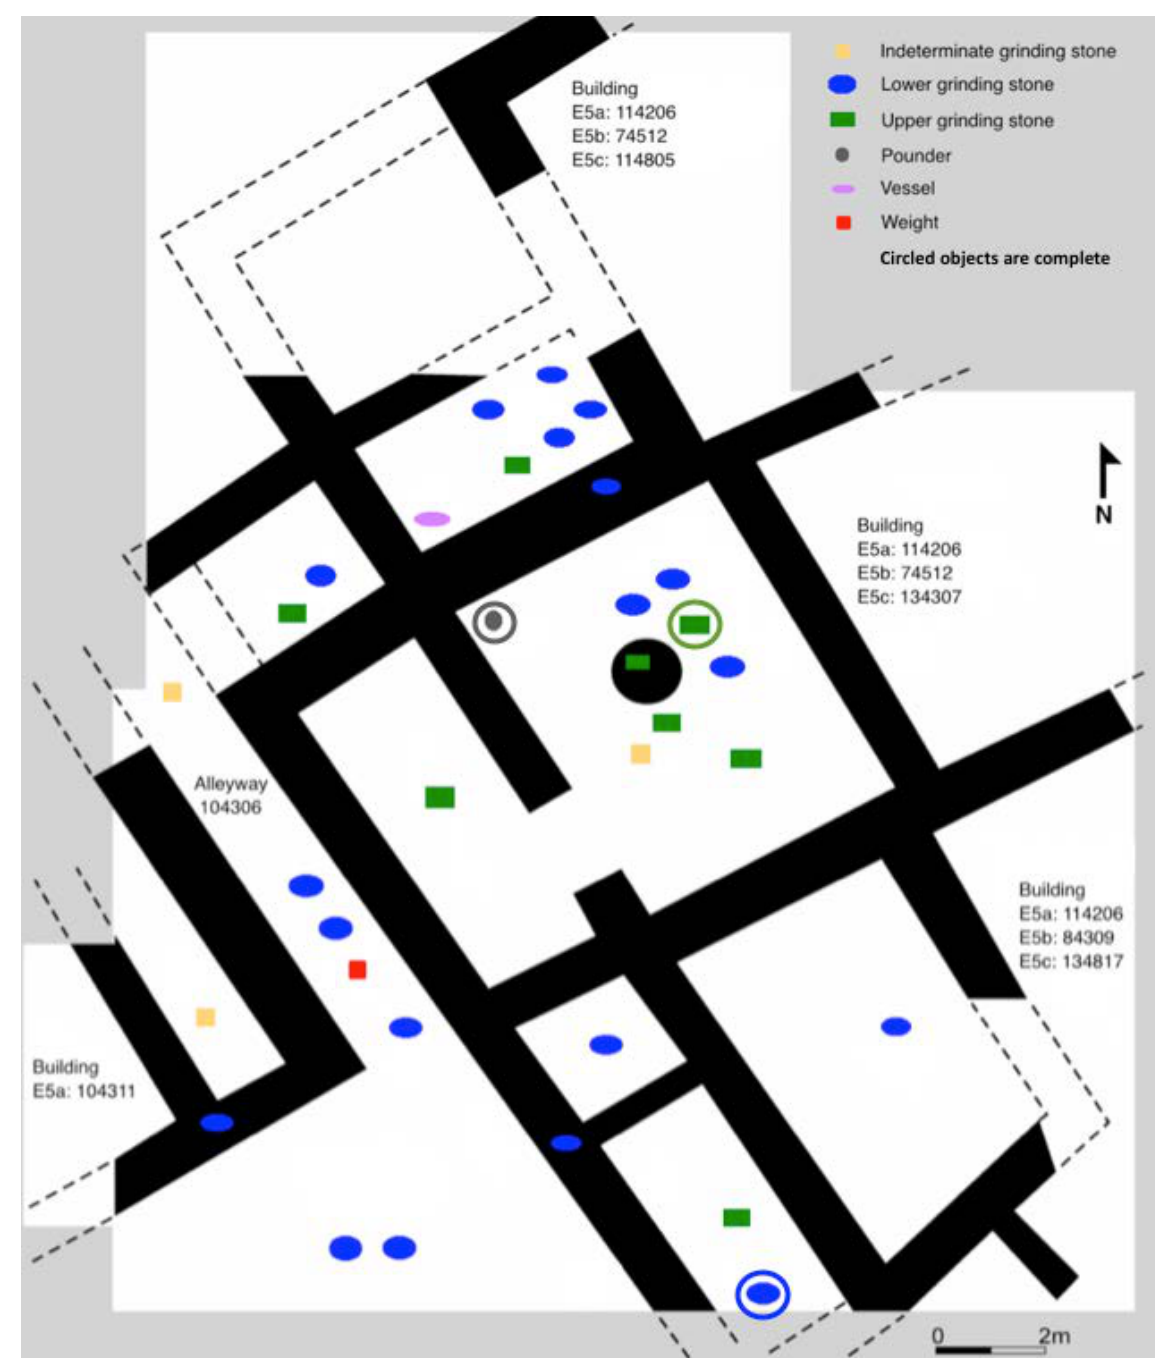
Figure 3. Distribution of basalt artefacts within Tell es-Safi/Gath